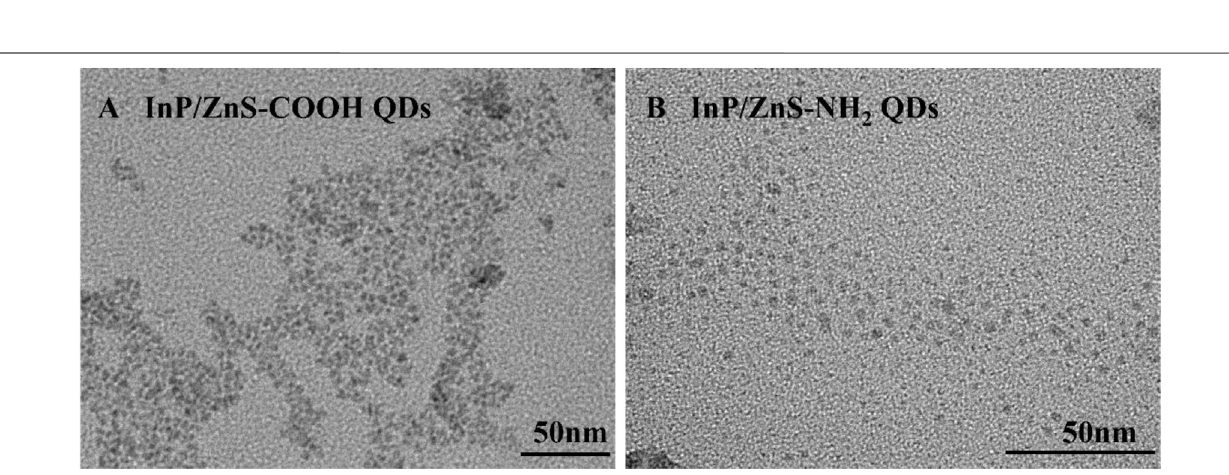
Frontiers in Bioengineering and Biotechnology |